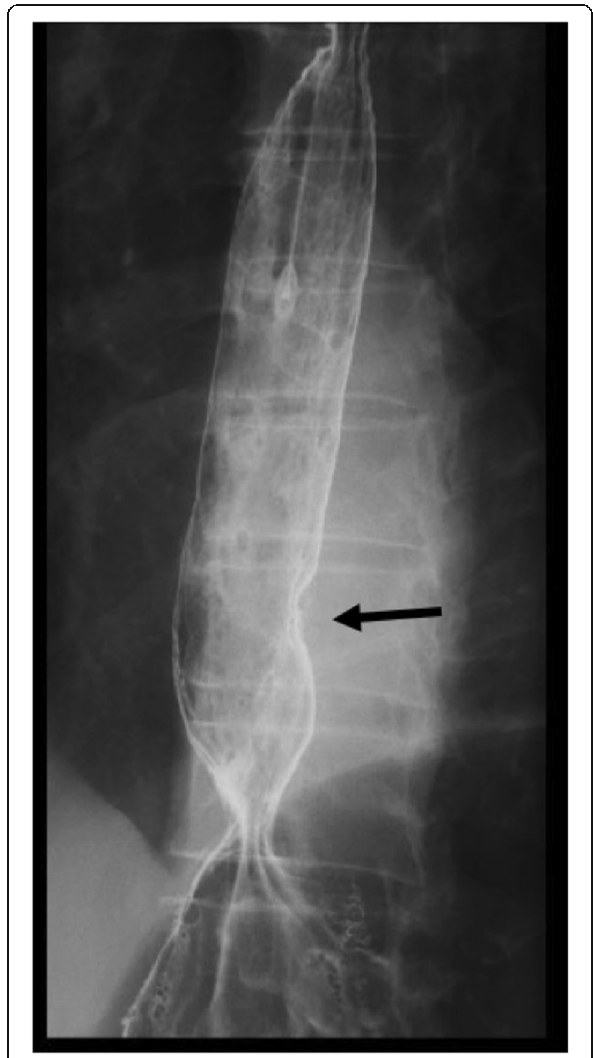
Fig. 2 Esophagography. Esophagography showed a type 0-IIa + IIc elevated lesion (15 mm in size) on the left wall of the lower esophagus, and the tumor exhibited arcuate change suggesting submucosal